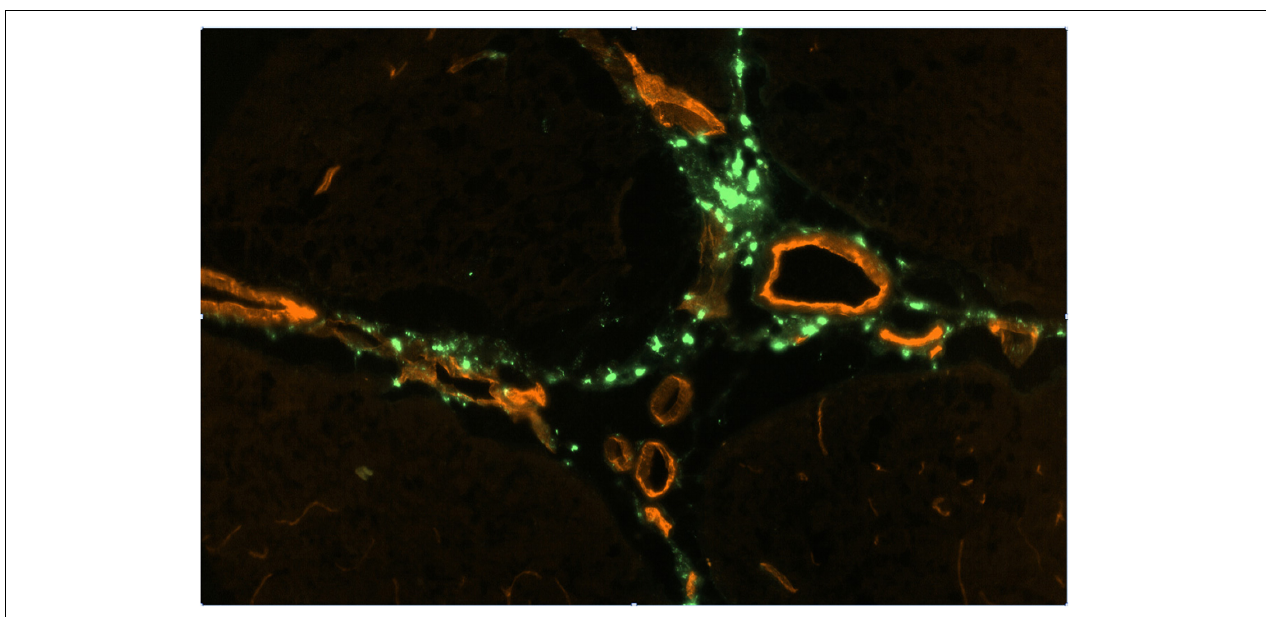
FIGURE 2 | FITC-rhNAGLU accumulation (green) around major blood vessels (red) in the perivascular conduits extending from the subhippocampal cistern. Unstained unfixed 20 µ m sagittal cryosection 3 mm off the central plane, 0.9 mm × 0.6 mm (see Supplementary Figure S6 for the anatomical